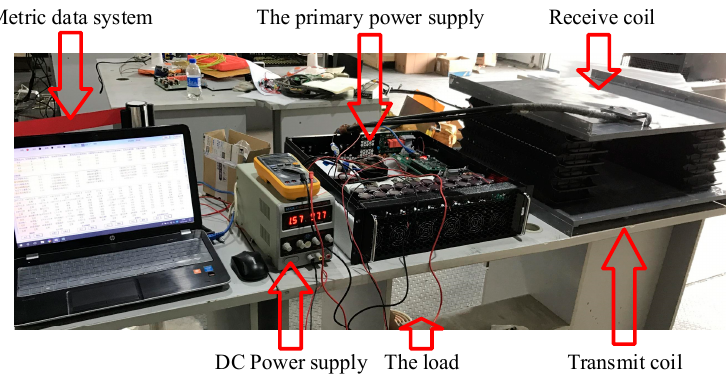
Figure 15. A Witricity-based high-power device for the wireless charging of electric vehicles. Table 2. The measured parameters of the input side and the output side.